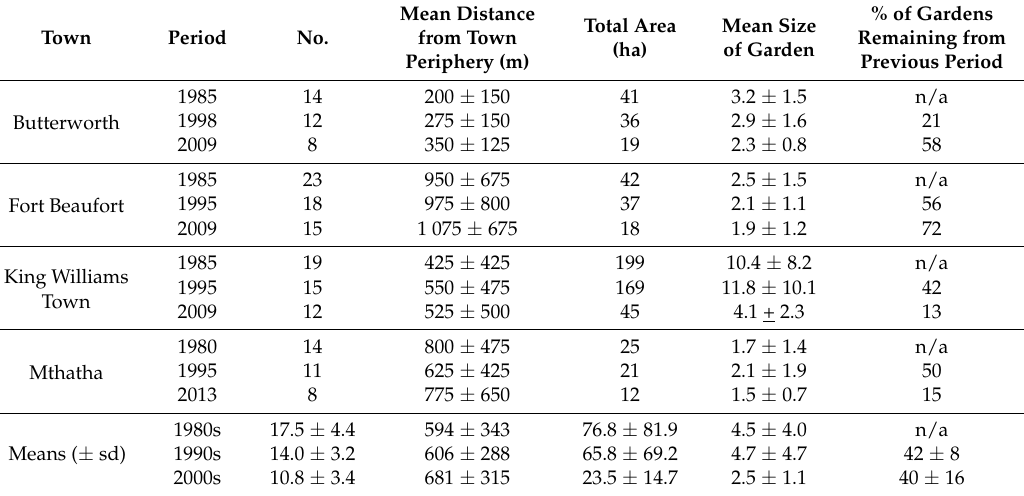
Table 2. Change in community garden attributes across three time